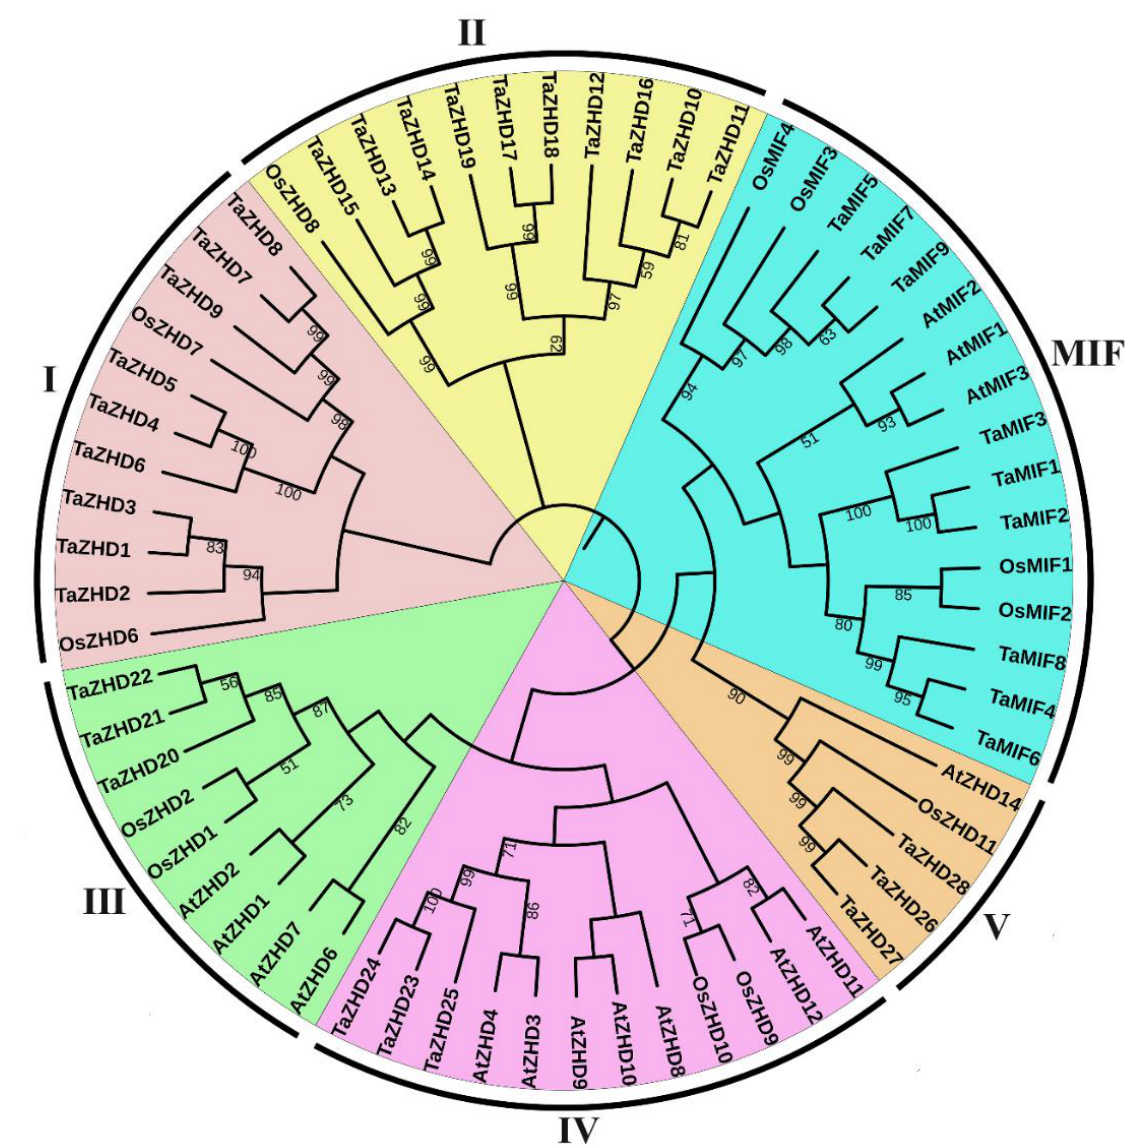
Figure 1. The neighbor-joining (NJ) phylogenetic tree of ZF-HD proteins. The tree was constructed with amino acid sequences of identified ZF-HD proteins from in A. thaliana (At), O. sativa (Os) and T. aestivum (Ta) and bootstrap values of 1000 replicates. Different groups of ZF-HD proteins are distinguished by different colors.